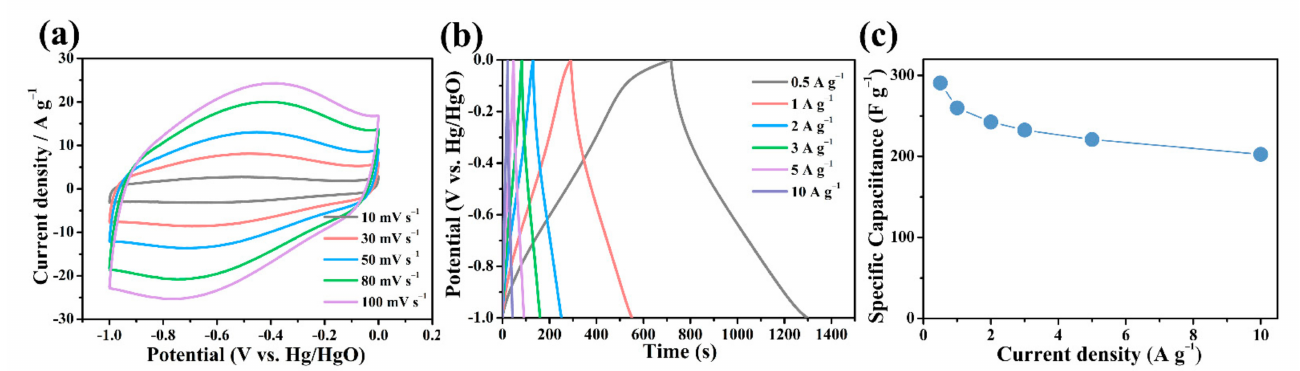
Figure 6. ( a ) CV and ( b ) GCD curves of B/S-SC S -1 at the different scan rates and current densities; ( c ) gravimetric capacitance as a function of specific